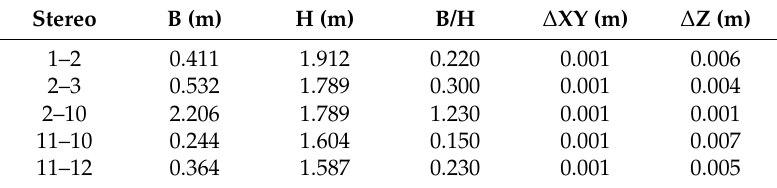
Table 4. Base-distance ratios and resolution of the stereo geometric model of test object.